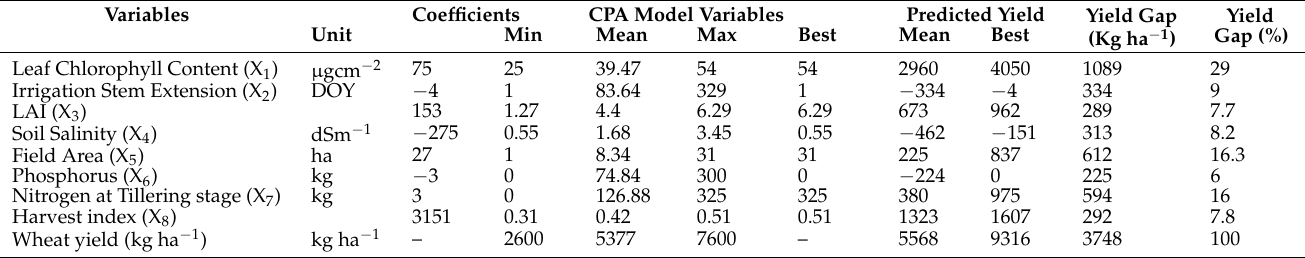
Table 2. The wheat yield gap numerical value and the fraction of each independent variable to contributing to the CPA output